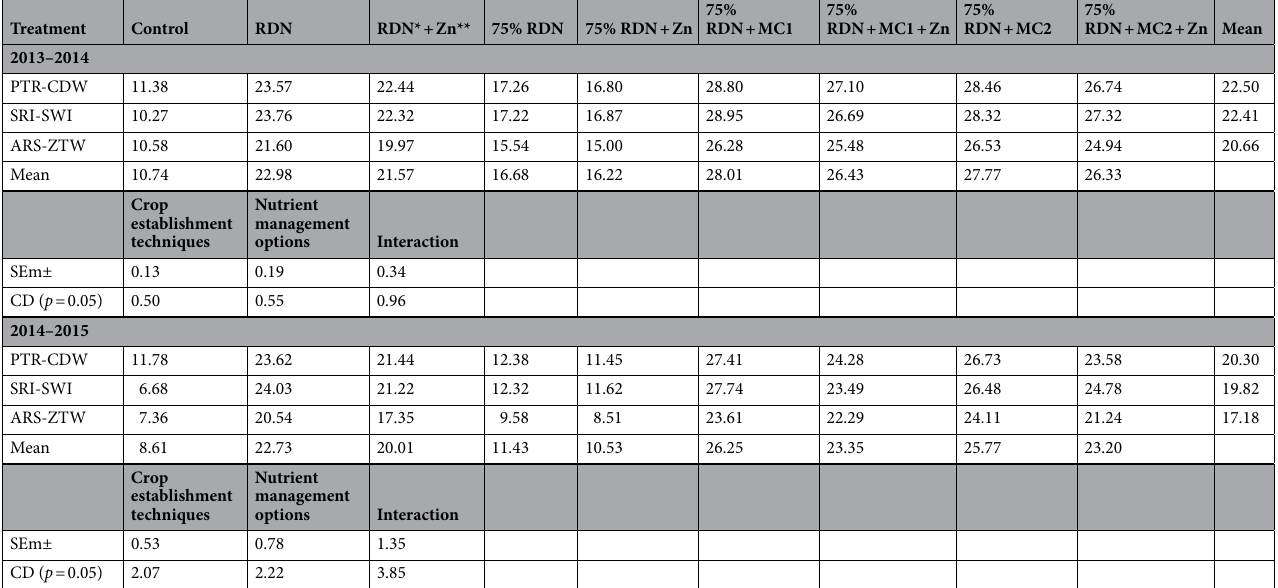
Table 7. Influence of crop establishment techniques and nutrient management options on soil phosphorus (kg ha −1 ) (Olsen’s NaHCO 3 -extractable) after completion of first and second cycle of rice–wheat cropping system. PTR , puddled transplanted rice; SRI , system of rice intensification; ARS , aerobic rice system; CDW , conventional drill-sown wheat; SWI , system of wheat intensification; ZTW , zero tillage wheat; RDN*